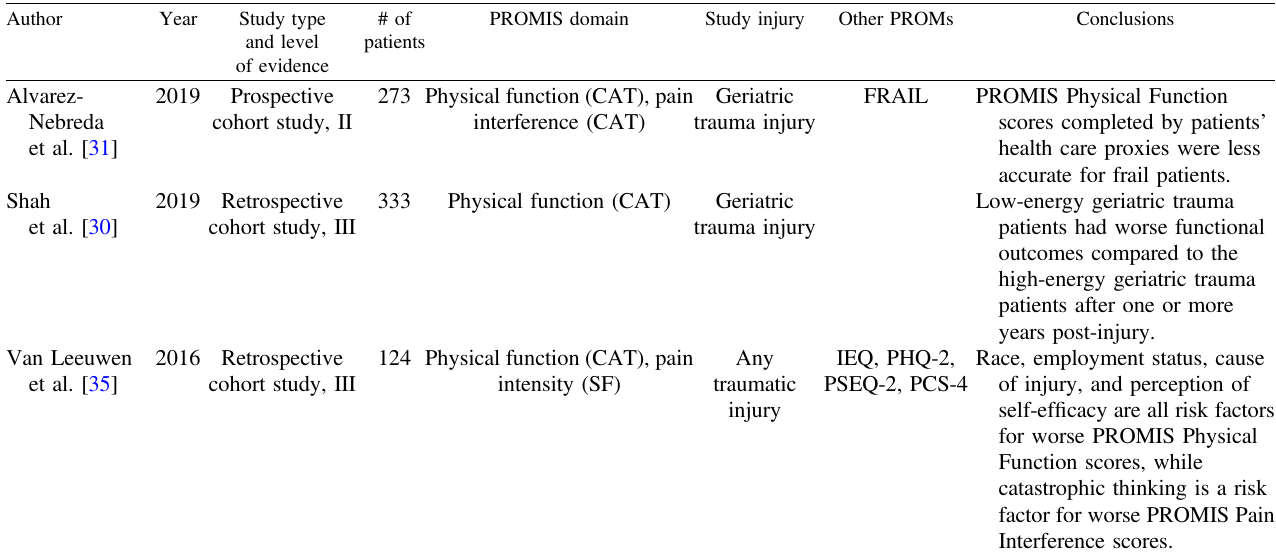
Table 3. PROMIS – additional